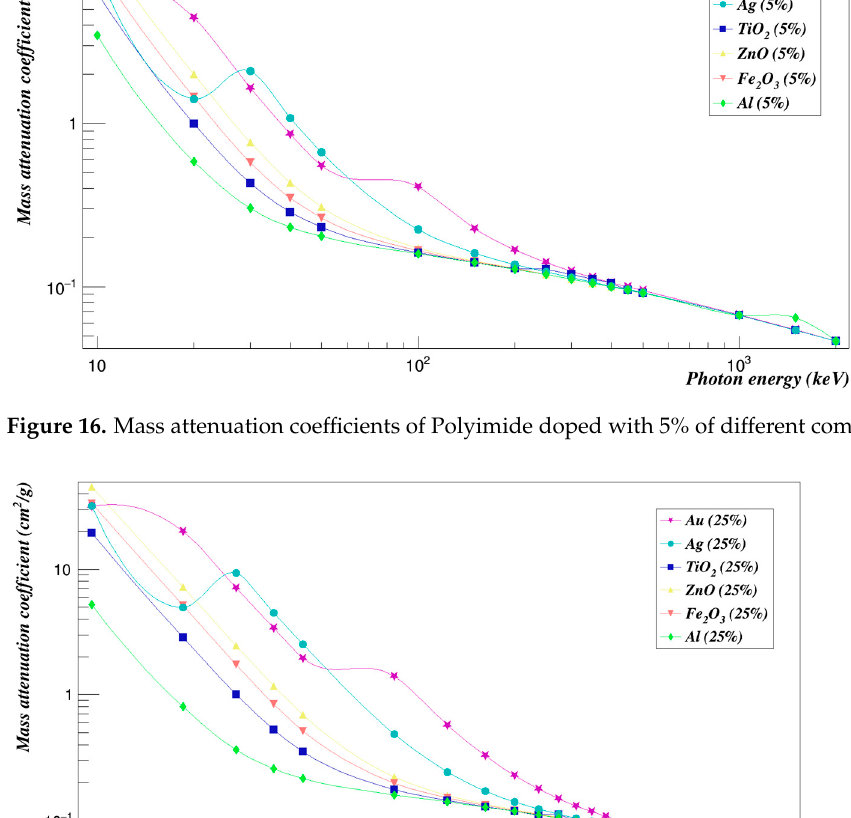
Figure 19. E ff ective removal cross sections of Polyimide doped with 25% of di ff erent composites. 4. Discussion In this work, the photon and neutron shielding properties of Polyimide were studied at the energy range between 10 and 2000 keV. The photon characteristics of Polyimide were investigated utilizing the mass a tt enuation coe ffi cients, half-value layers, e ff ective atomic numbers, and e ff ective electron densities to show the ability of Polyimide to act as a photon shielding material. Polyimide has excellent shielding performance for neutrons and is also superior to Polyimide doped with various composites. The EpiXS and Geant4 results agree very well. Using the Geant4 powerful toolkit based on the Monte Carlo method, we examined the photon and neutron shielding capabilities of polymer composite materials based on Polyimide with varied (Al, Fe 3 O 4 , ZnO, TiO 2 , Ag and Au) composite contents with weight fractions of (5, 10, 15, 20, and 25%). The shielding properties of the Polyimide were very promising, and the addition of di ff erent composites enhanced its photon shielding properties. However, it was observed that the e ff ect of the addition of composites on the mass a tt enuation coe ffi cients of Polyi- mide is very large at low photon energies, then starts to decrease as the energy increases